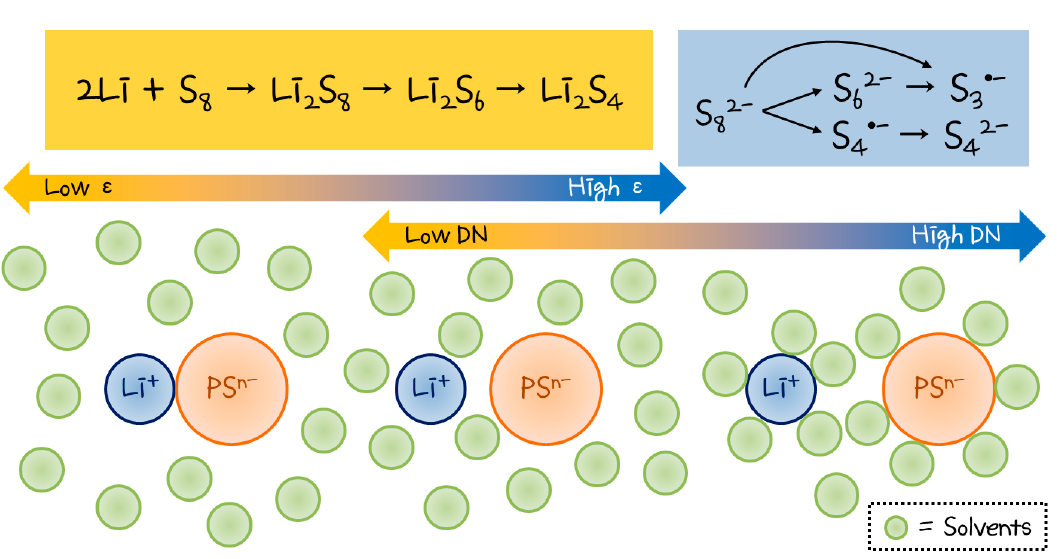
Figure S1: Optimized geometries of (a) neutral, (b-d) singly-charged, and (e-i) doubly-charged polysulfides in DMSO. Figure S2: Optimized geometries of (a) [Li-(ACN)n] + and (b) [Li-(DMSO)n] + clusters with di ff erent solvent coordination numbers (n). Table S1: Theoretical values and the reported experimental results of reduction potentials ( ∆ E, in V) of S8, S82-, and S3 • - in di ff erent